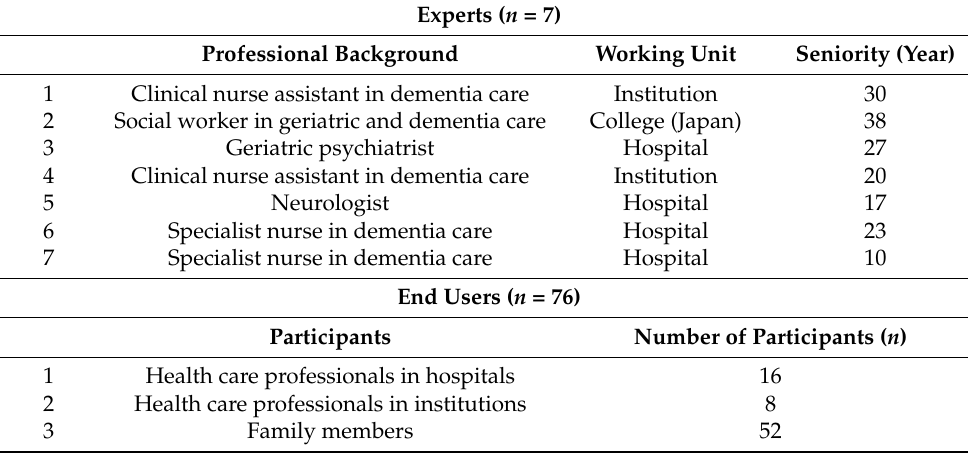
Table 4. Characteristics of the participants involved during the validation process.